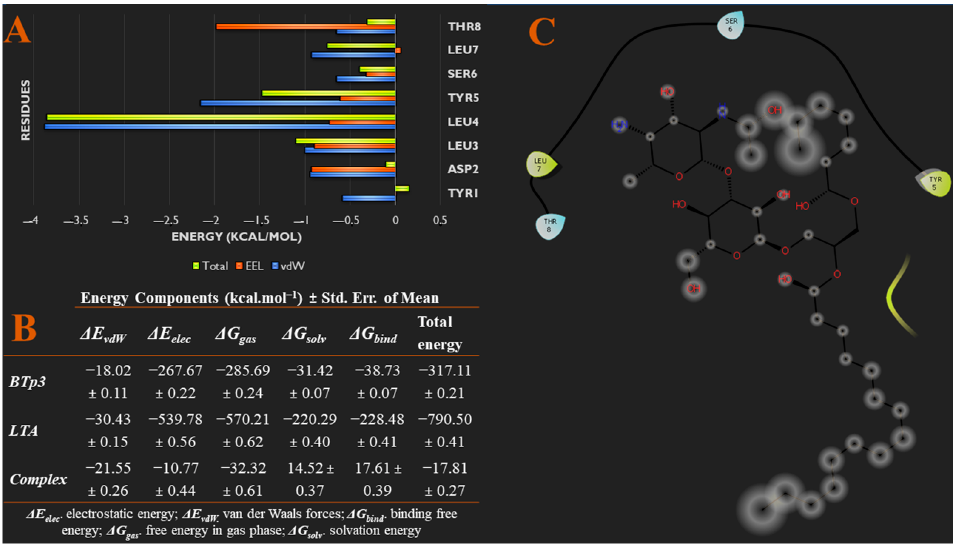
Figure 6. ( A ) Per-residue energy decomposition analysis showing specific energy contributions of each amino acid residue of BTp3 that contributes to binding. ( B ) Different energy contributions of each component of the system via MM/GBSA thermodynamics. ( C ) Binding interaction diagram of BTp3 to residues of TLR2.